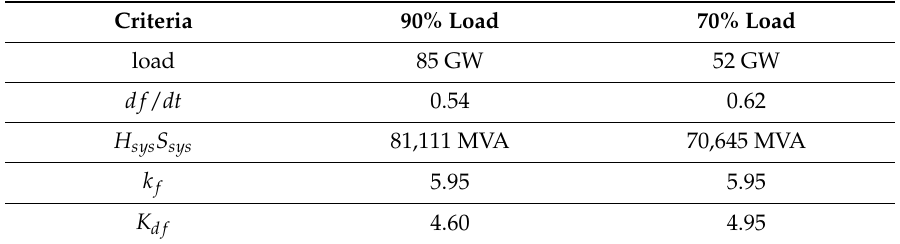
Figure 7. The current frequency regulation (FR)-ESS installation in Korea. Table 1. Comparison of load condition.